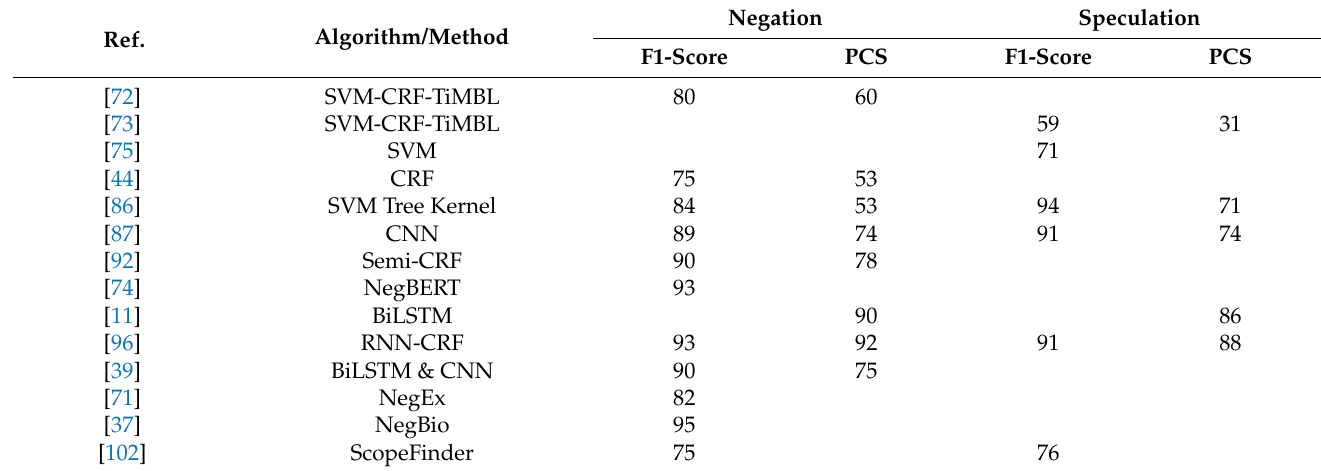
Table 6. Detection of negation and speculation scope systems for the BioScope corpus.